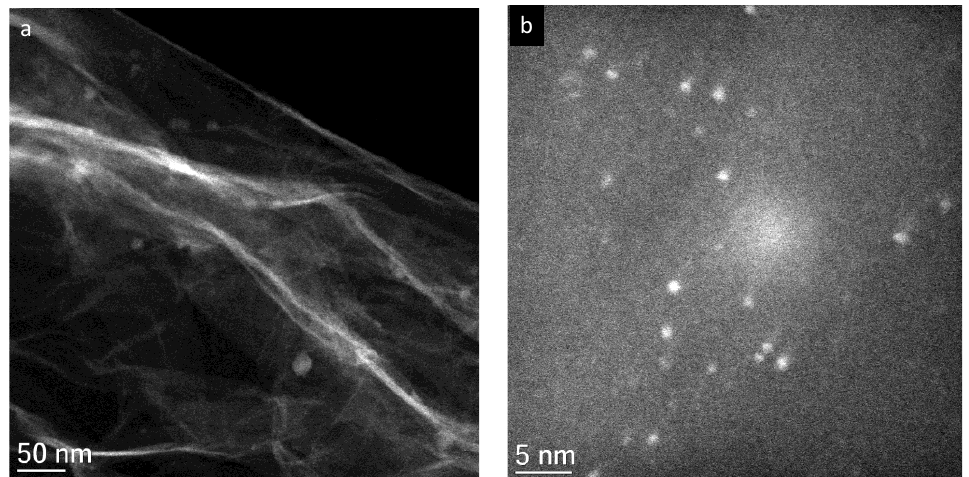
Figure 8. Deconvolution of the N1s XPS core level spectra.